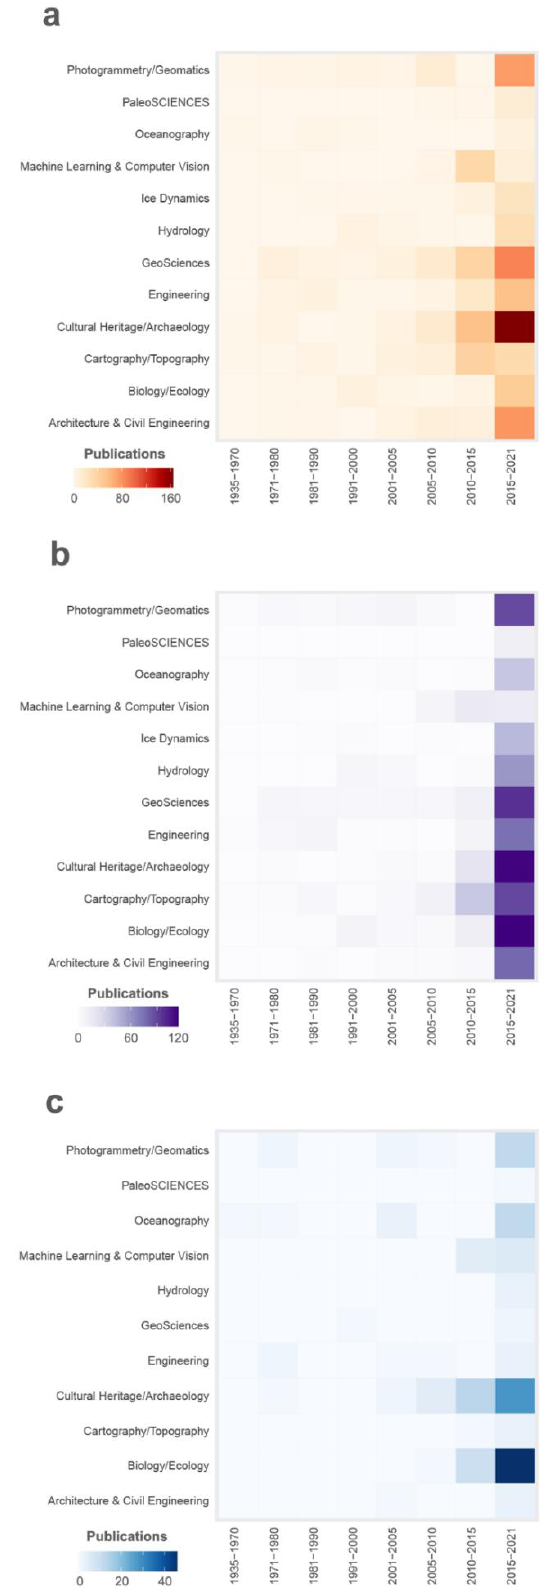
Figure 4. Number of publications per year and the discipline in which the study was framed. ( a ) Ground-based applications, ( b ) airborne-photogrammetry applications, and ( c ) underwater.